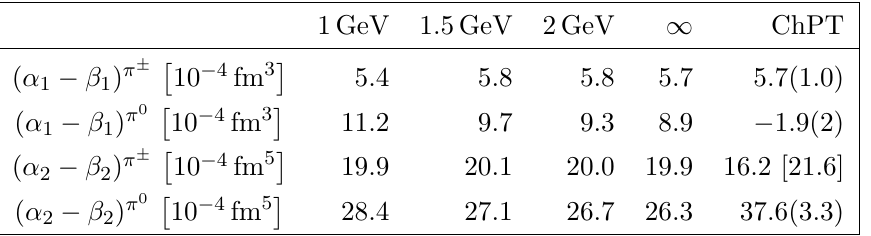
Table 5. Pion polarizabilities from the sum rules (4.19) for a pion-pole LHC and di(cid:11)erent values of the cuto(cid:11) (cid:3), in comparison to the chiral two-loop prediction from [136, 137]. The two numbers in the case of the charged-pion quadrupole polarizability refer to two di(cid:11)erent sets of low-energy